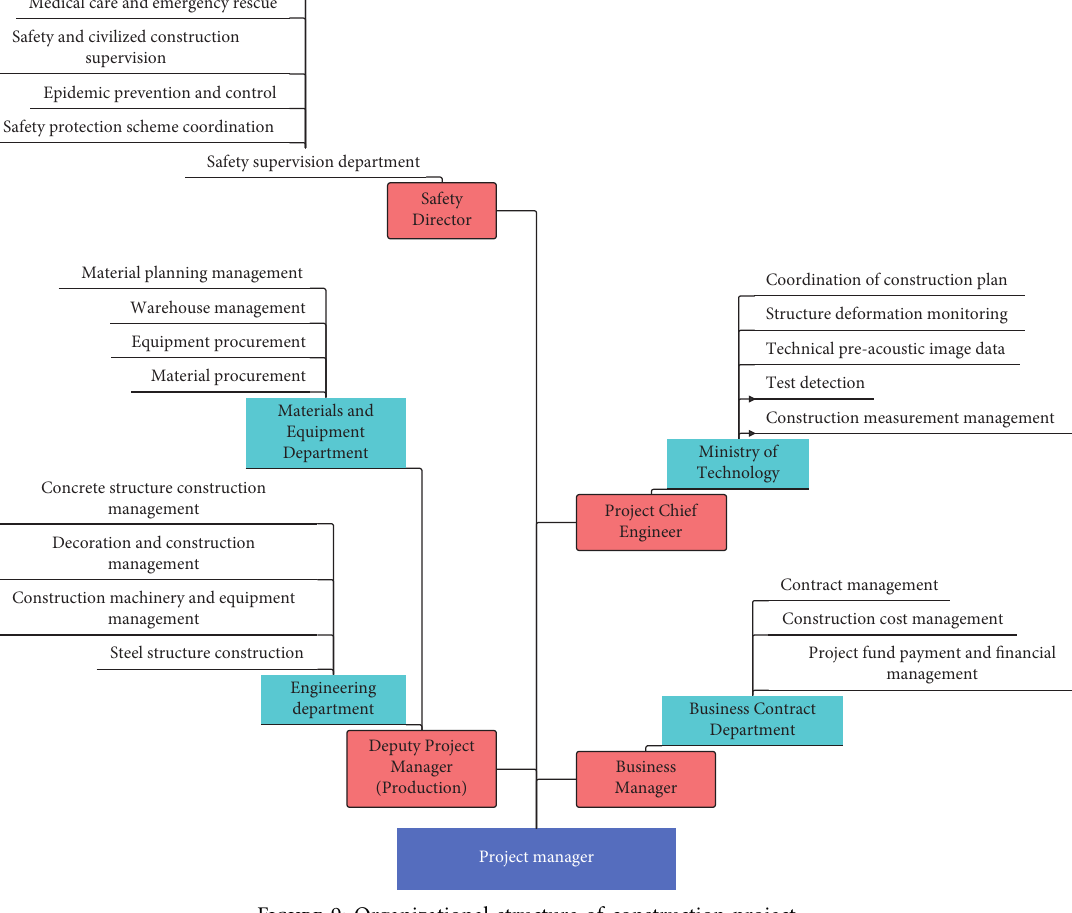
Figure 9: Organizational structure of construction project.